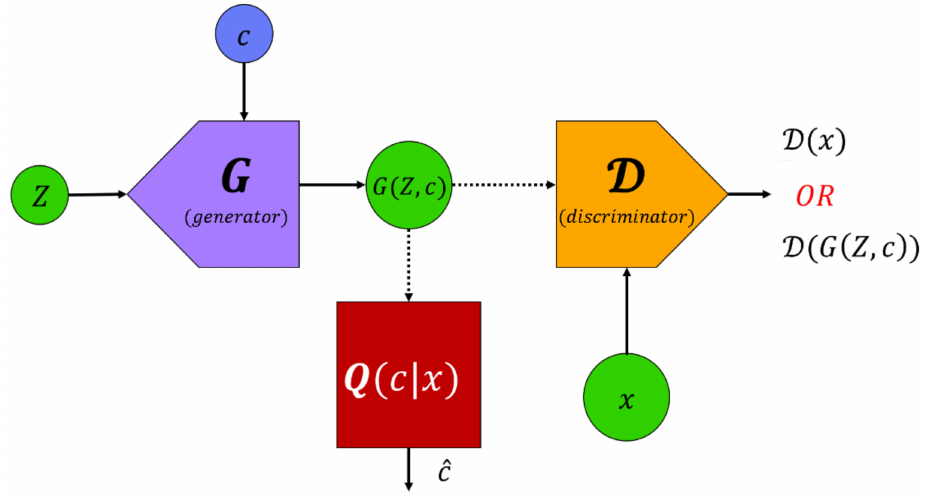
Figure 9. Structure and principle of InfoGAN (Information maximizing Generative Adversarial